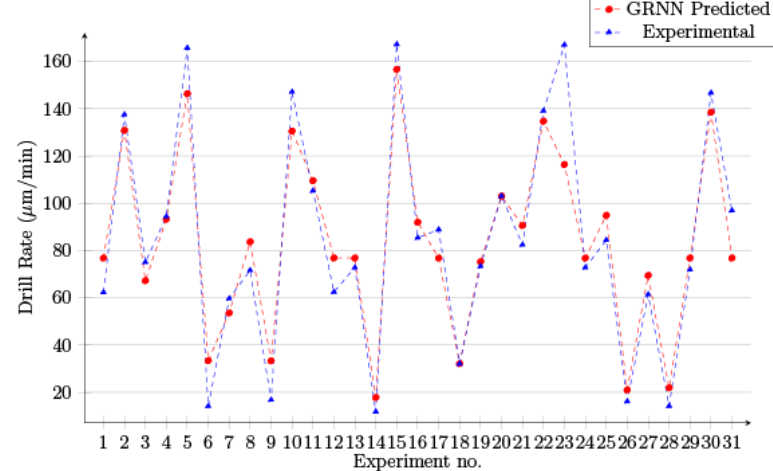
Figure 5. GRNN model testing for DR with different smoothing factors.